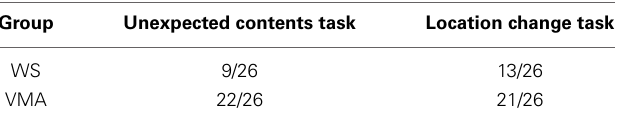
Table 2 | Performance on two theory of mind tasks.